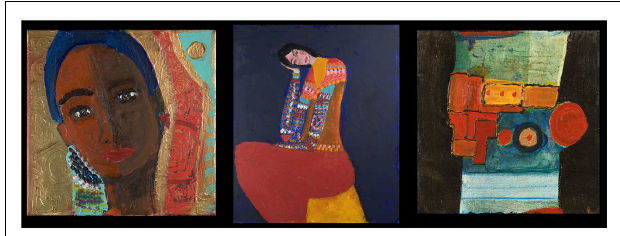
FIGURE 1 |Three works from her first, non-addictive period